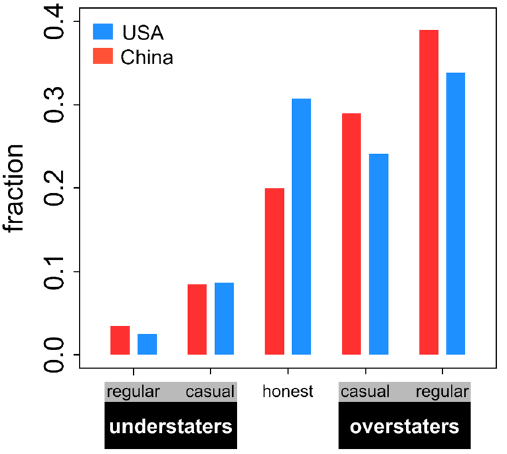
Figure 2. Most participants across both cultures tend to overstate the contributions they made to the group project. Bars show the fractions of individuals that were ‘understaters’ (understating their contribution more often than they overstated them) ‘honest’ (individuals who understated and overstated equally often, which are mostly made up of individuals who never misrepresented at all) and ‘overstaters’ (overstating more often than understating). ‘Regular’ understaters are defined as individuals who understated in at least five more rounds than they overstated, while ‘casual’ understaters are individuals who understated in fewer than five more rounds than they overstated (the same reasoning applies to overstaters). The figure shows pooled data for the treatments with and without the possibility for